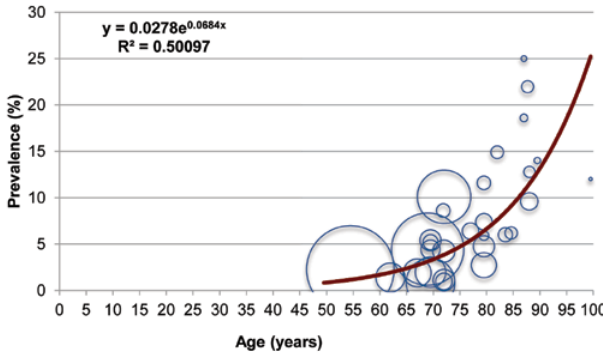
Figure 3 Age–specific prevalence of dementia in Africa based on the information from 10 studies, with sample size underlying each data point presented by the size of each bubble.